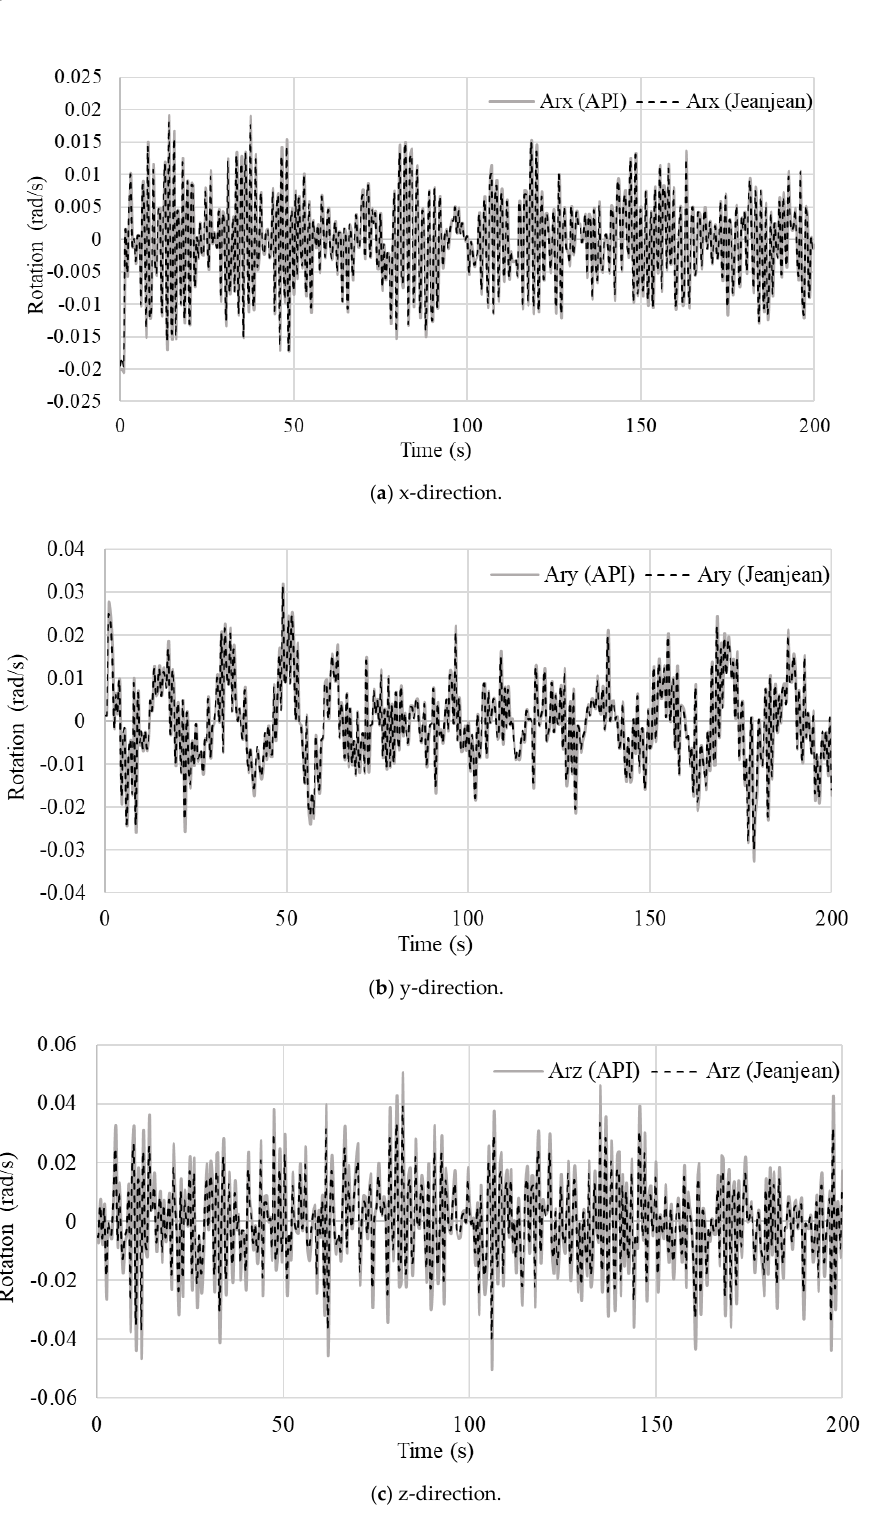
Figure 20. Rotational acceleration components at the interface.